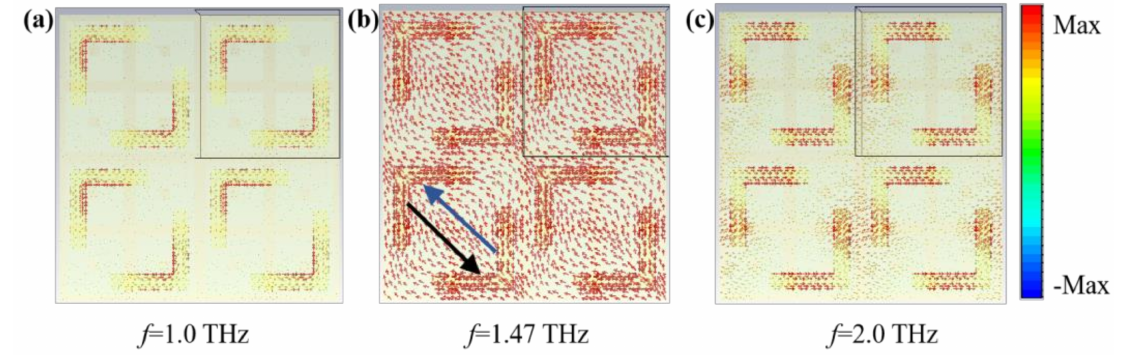
Figure 6. Surface current distribution on the gold square aperture ring structure at ( a ) 1 THz, ( b ) 1.47 THz, and ( c ) 2 THz